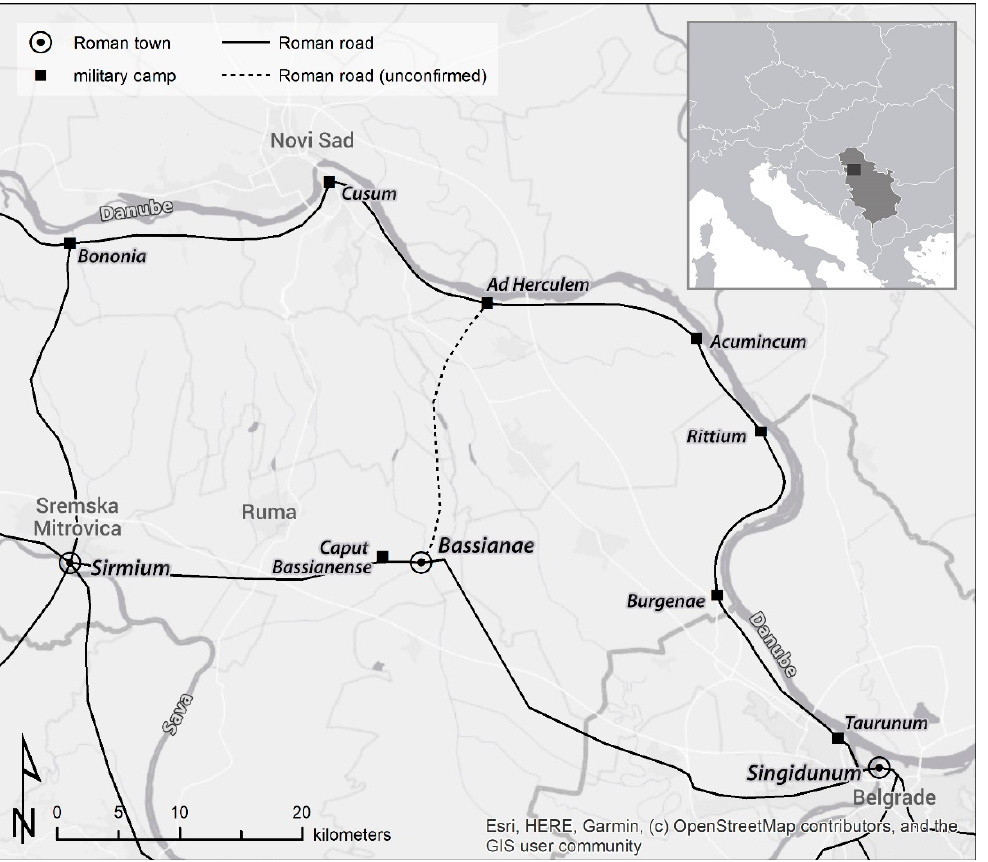
Figure 1. Location of Bassianae between Singidunum and Sirmium in present-day Serbia. Due to its location, Bassianae kept its importance in the following century. However, Sarmatian raids in AD 374-375 and the Goths’ movements after AD 378 must have affected the town and its territory. This crisis of the Later Roman Empire was characterized by the presence of new population groups, mostly of Germanic origin, and the impoverishment of the entire Roman province Pannonia Secunda . It is very illustrative that the Notitia Dignitatum (or. XI.46) [4] mentions the transfer of the late antique textile factory of Bassianae (Lat. gynaecium Bassianense ) to the safety of Salona on the Adriatic coast. Invasions by, and fights against, the Ostrogoths and Huns during the 5th century AD would only add more burden to the region’s population [2,3]. After the Roman Empire re-establishes control over the Bassianae area in AD 510, the town slowly vanishes from the